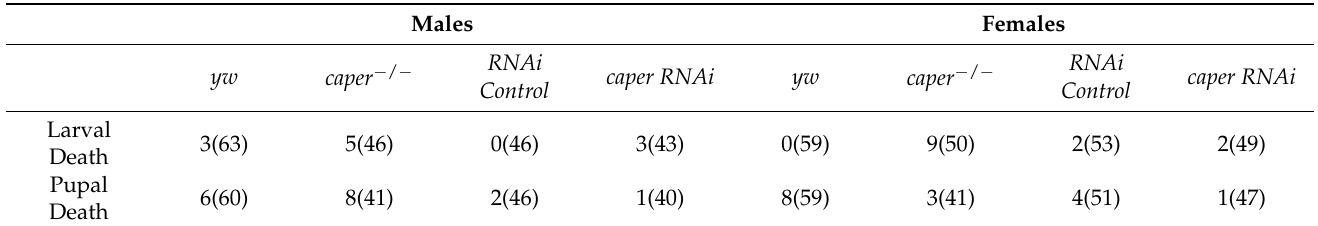
Table 1. caper is required for viability during larval stages but is dispensable during pupariation. Males Females RNAi yw caper − / − caper RNAi yw caper − / − Control